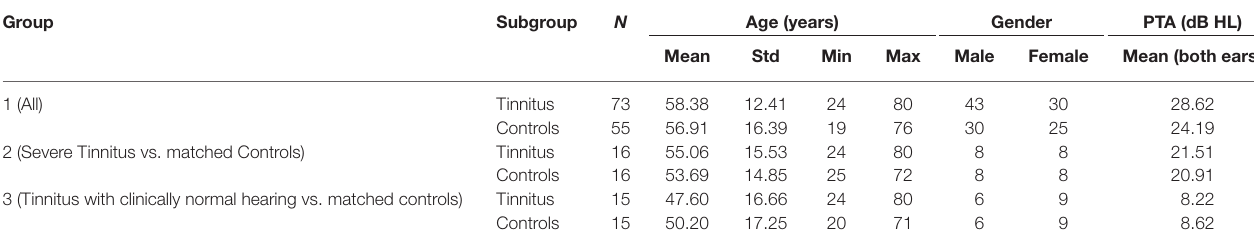
TABLE 1 | Demographic information and hearing status for each of the three groupings. Group